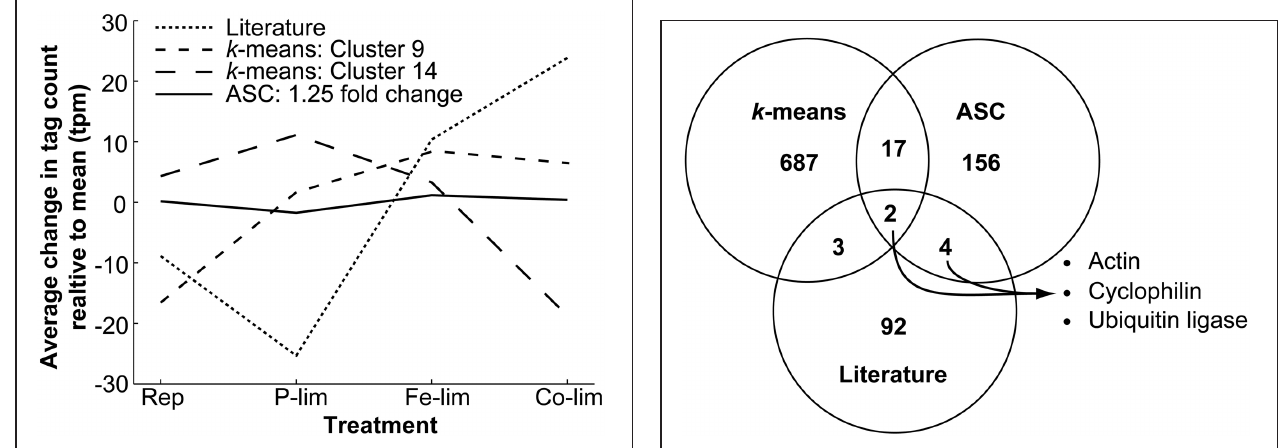
FIGURE 2 | Average deviation from the mean level of expression for all genes found with literature-based searches, k -means clustering, and ASC analysis of 1.25 fold change. The average change in tag count from the mean expression (tpm) for all the genes identified through literature-based searches for genes homologous to known reference genes from the literature ( n = 101), k -means clustering from Cluster 9 ( n = 243) and Cluster 14 ( n = 466), and ASC analysis identifying genes demonstrating a 1.25 fold change with a post- p < 0 . 1 ( n = 179). The mean standard deviations for the four cases are as follows: Literature (92.62tpm), Cluster 9 (41.66tpm), Cluster 14 (43.12tpm), and ASC (14.24tpm). The mean tpm is plotted for the four treatments: Replete (Rep), P-limited (P-lim), Fe-limited (Fe-lim), and Co-limited (Co-lim).